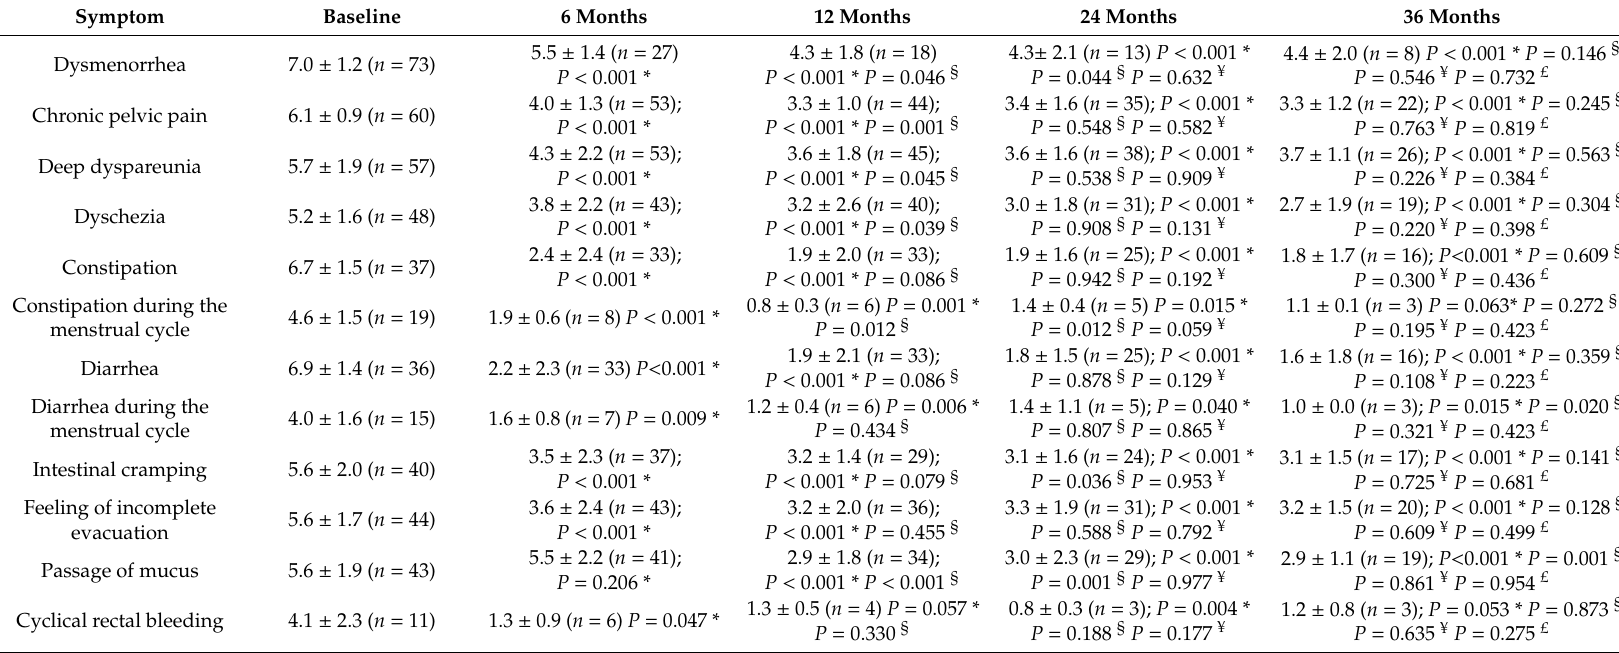
Table 2. Changes in pain and gastrointestinal symptoms during the